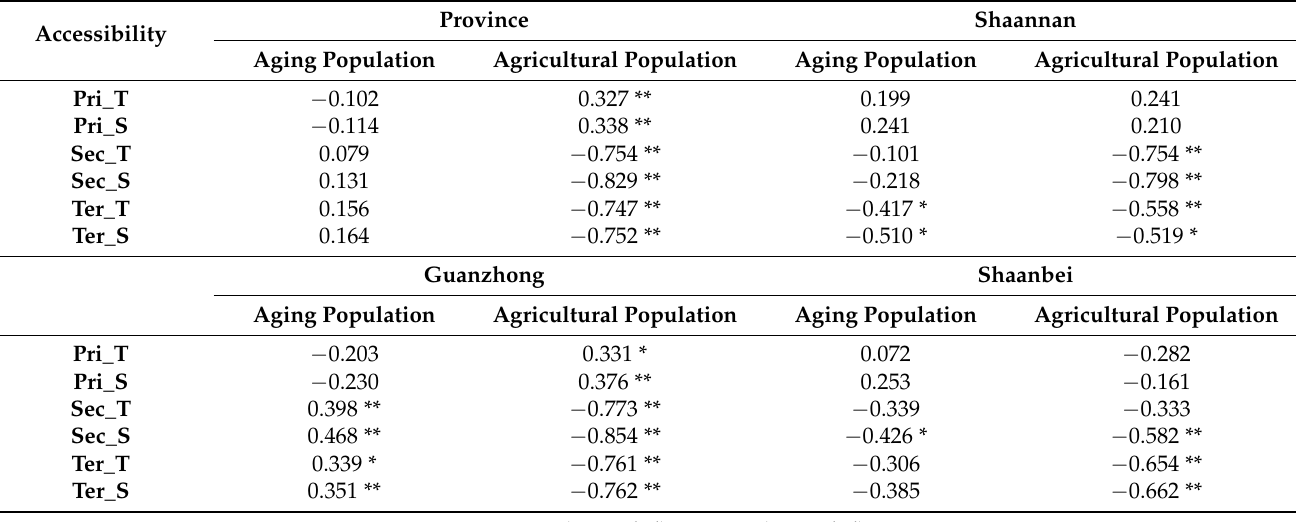
Table 3. Correlation analysis between population and